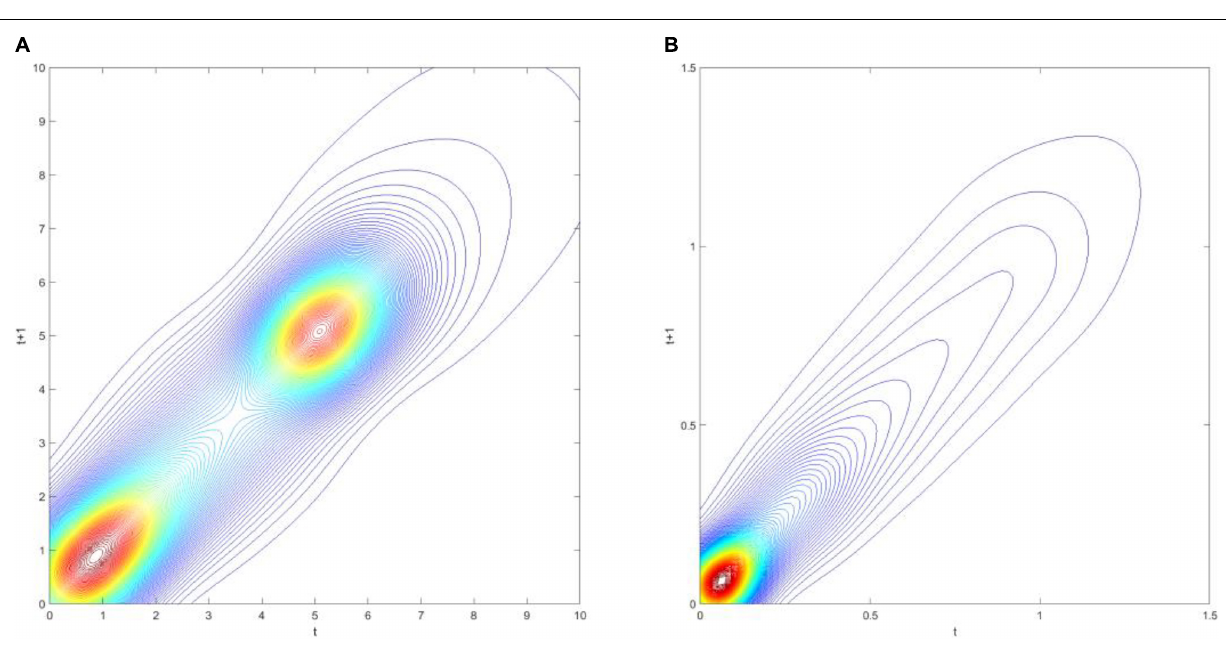
FIGURE 8 | Contour map of transition probability kernel for the RSVAPC of countries for the Global North (A) and the Global South (B) with annual transitions. Source: Authors’